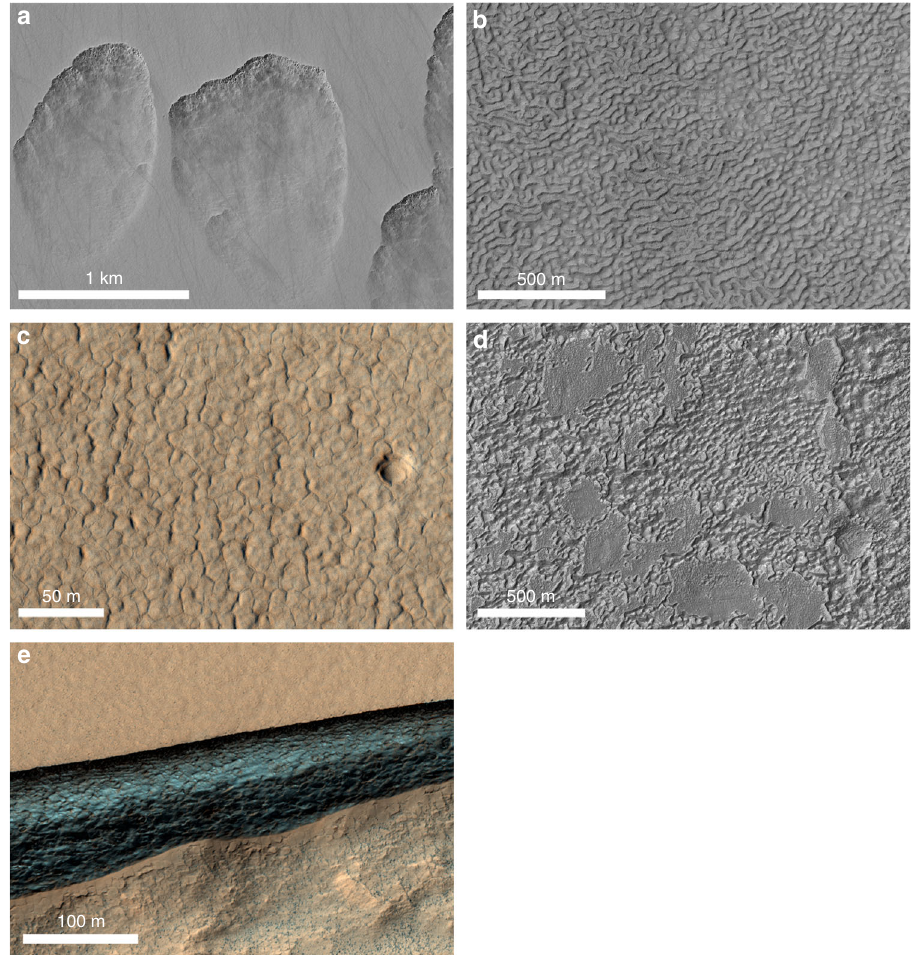
Fig. 1 Images of potential sublimation landforms on Mars. a Scallop terrain — kilometer-scale pits with pole-facing back-wasting scarps thought to be due to ice ablation (HiRISE Image ESP_013952_1225); b brain coral terrain — rif fl e-like curvilinear ridge-and-trough textures usually found at the margins of glacial fl ow features (HiRISE Image ESP_023649_1360); c polygonal patterned ground exhibiting high-relief thought to be due to ice wedge loss through sublimation and differential erosion (HiRISE Image PSP_008896_2250); d dissected mantle terrain — hummocky inter-plateau deposits believed to result from loss of ice cement and subsequent surface subsidence (HiRISE Image ESP_049606_1390). In all images north is up and illumination is from the